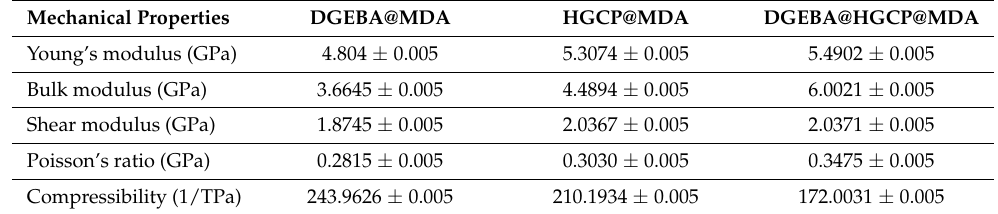
Figure S2: DSC thermograms of materials DGEBA@MDA, HGCP@MDA and